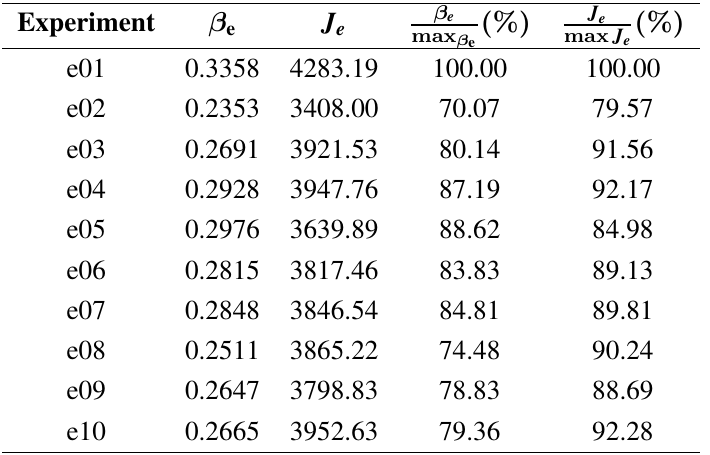
Table 3. Battery consumption slope and discrete integration per experiment.